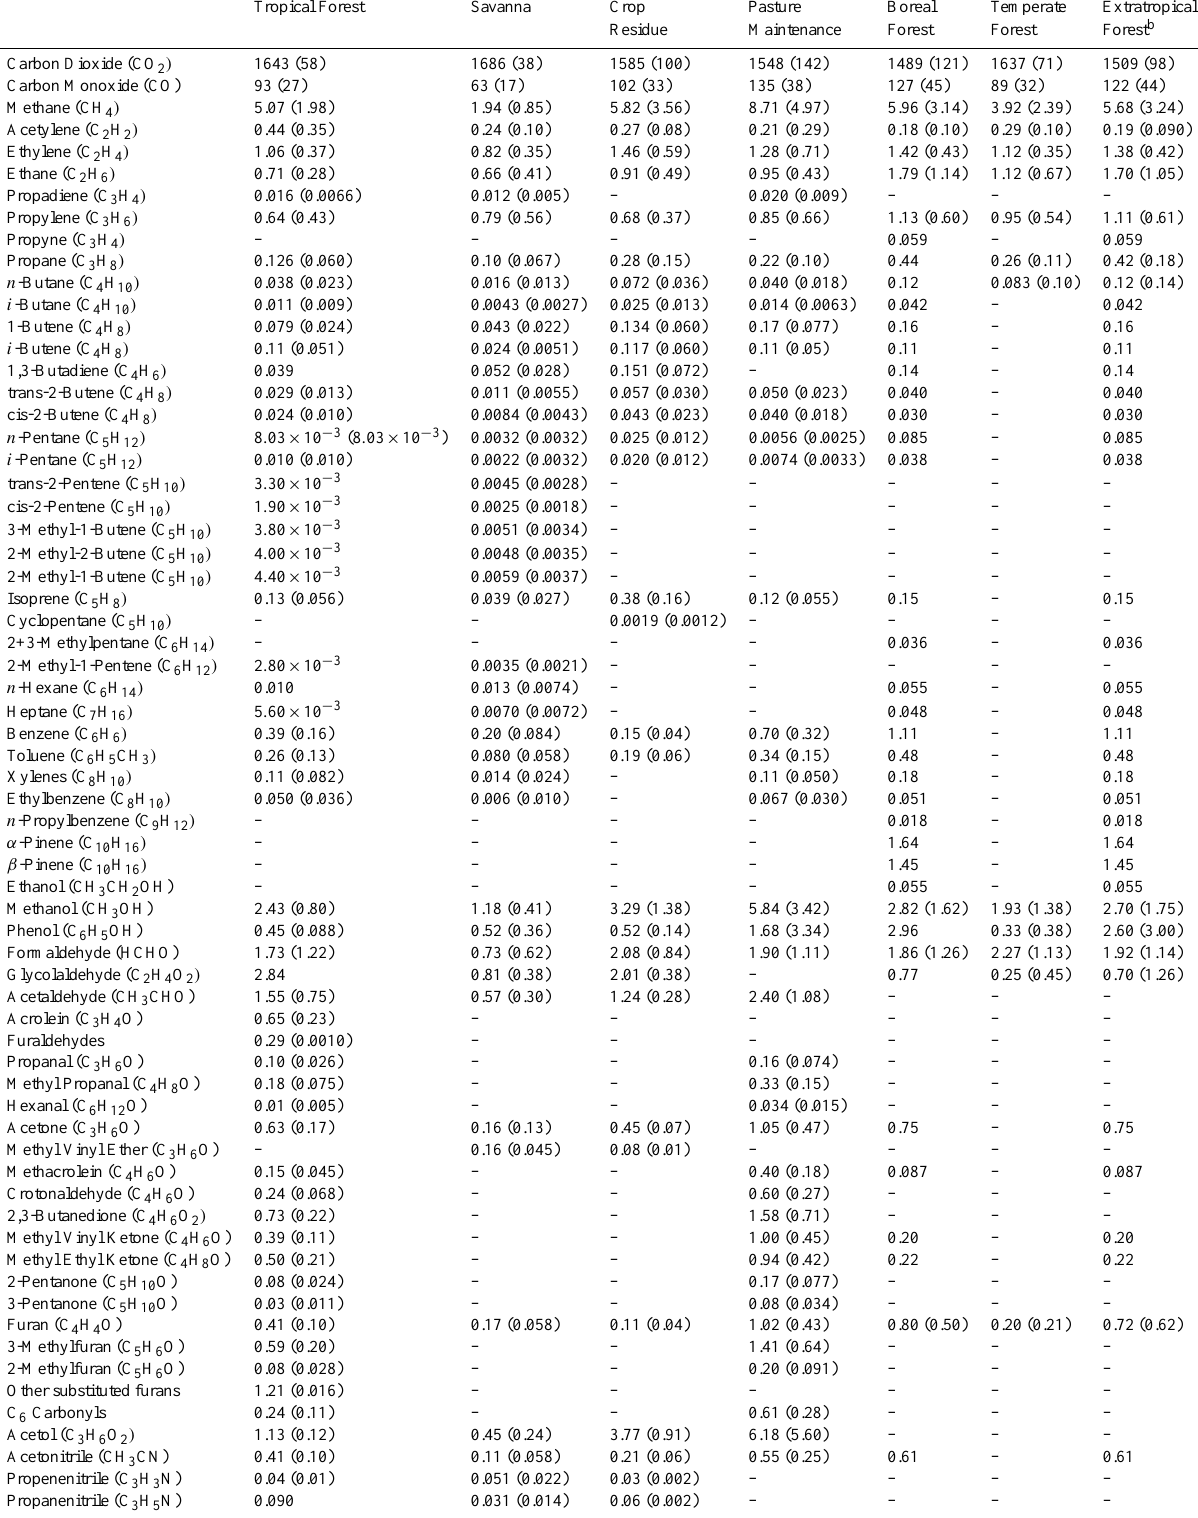
Table 1. Emission factors (gkg − 1 ) for species emitted from different types of biomass burning a